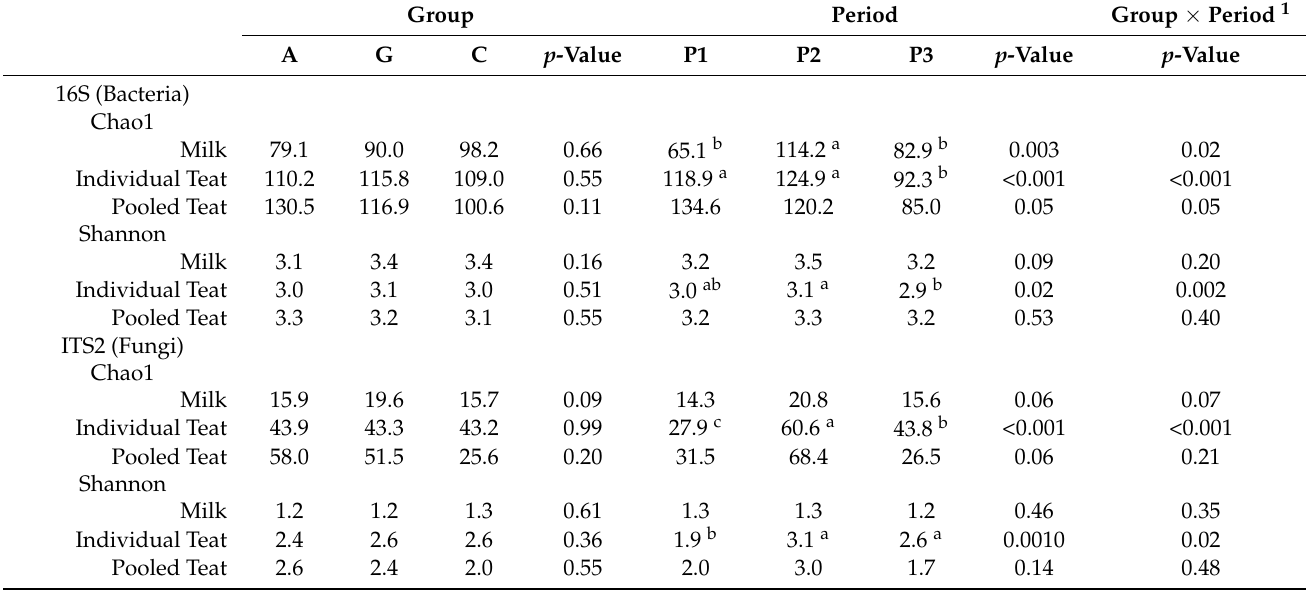
Table 4. Alphadiversity